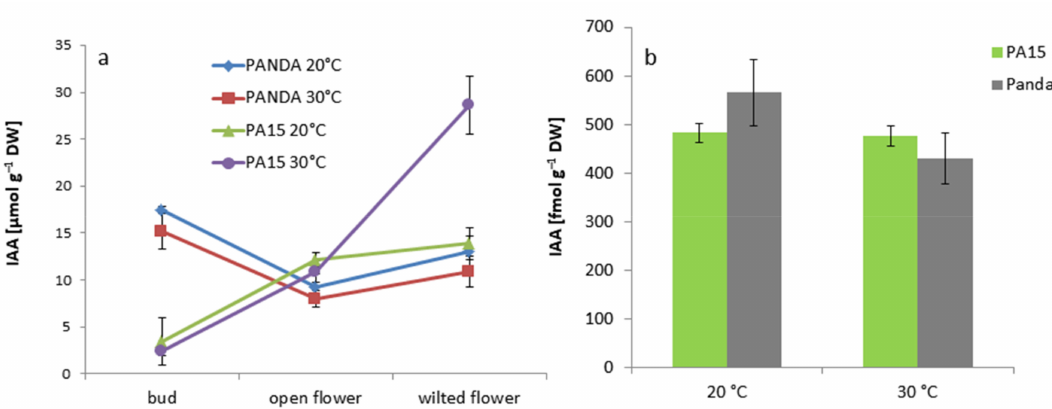
Figure 5. IAA [ µ mol g − 1 DW] in the flower buds, open flowers, and wilted flowers ( a ) and the leaves ( b ) of the ‘Panda’ and PA15 plants grown at 20 ◦ C (control) and 30 ◦ C (thermal stress). Means ( n = 3) ±